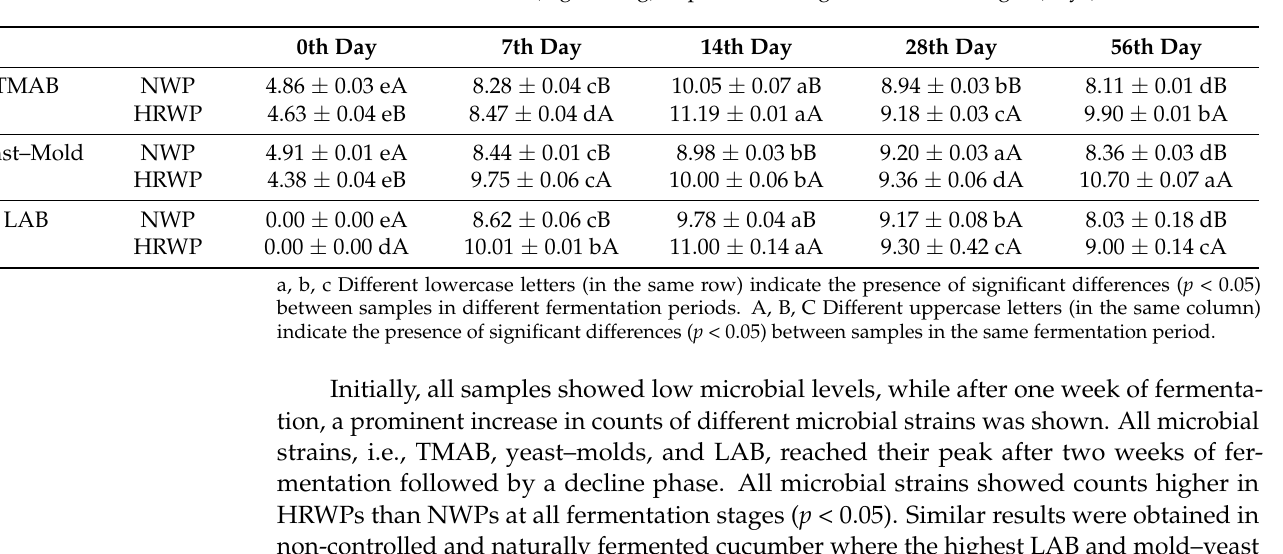
Table 2. Microbial counts (log CFU/g) of pickles during fermentation stages